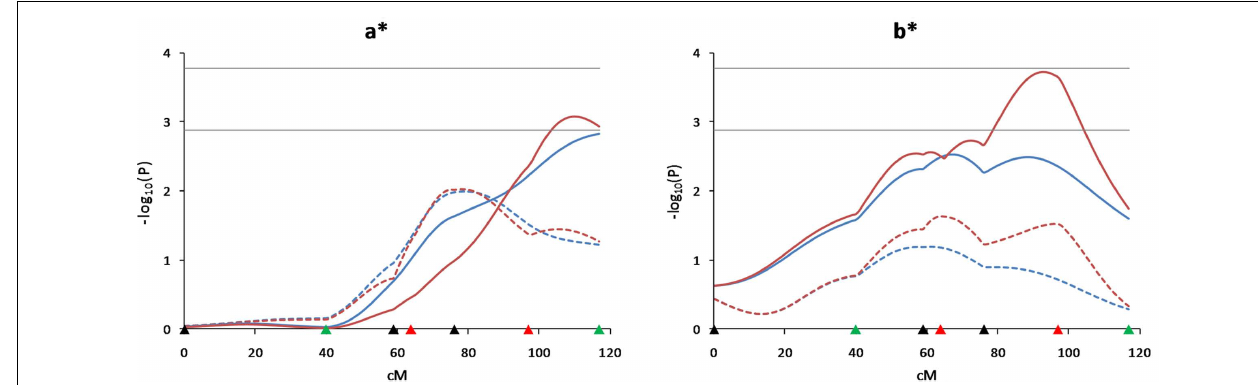
Solid lines indicate 948 animals and dotted lines indicate 510 animals. Marker positions are shown as triangles on the X -axis (black, markers used for both QTL scans and genotyped only in 510 animals; green, markers used for both QTL scans and genotyped in all animals; red, markers used for second scan only and genotyped in all animals). Horizontal lines indicate significance thresholds (lower line, 5% FDR; upper line, 1%